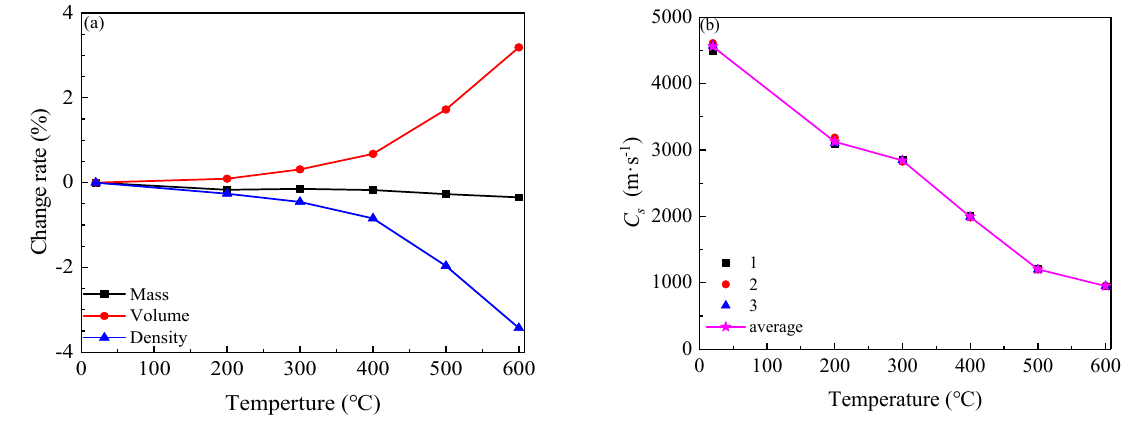
Figure 4. Relationship between physical properties and temperature. ( a ) Change rate of mass, volume and density; ( b ) Wave velocity of specimen. Table 1. Static physical and mechanical parameters of specimen after thermal shock.